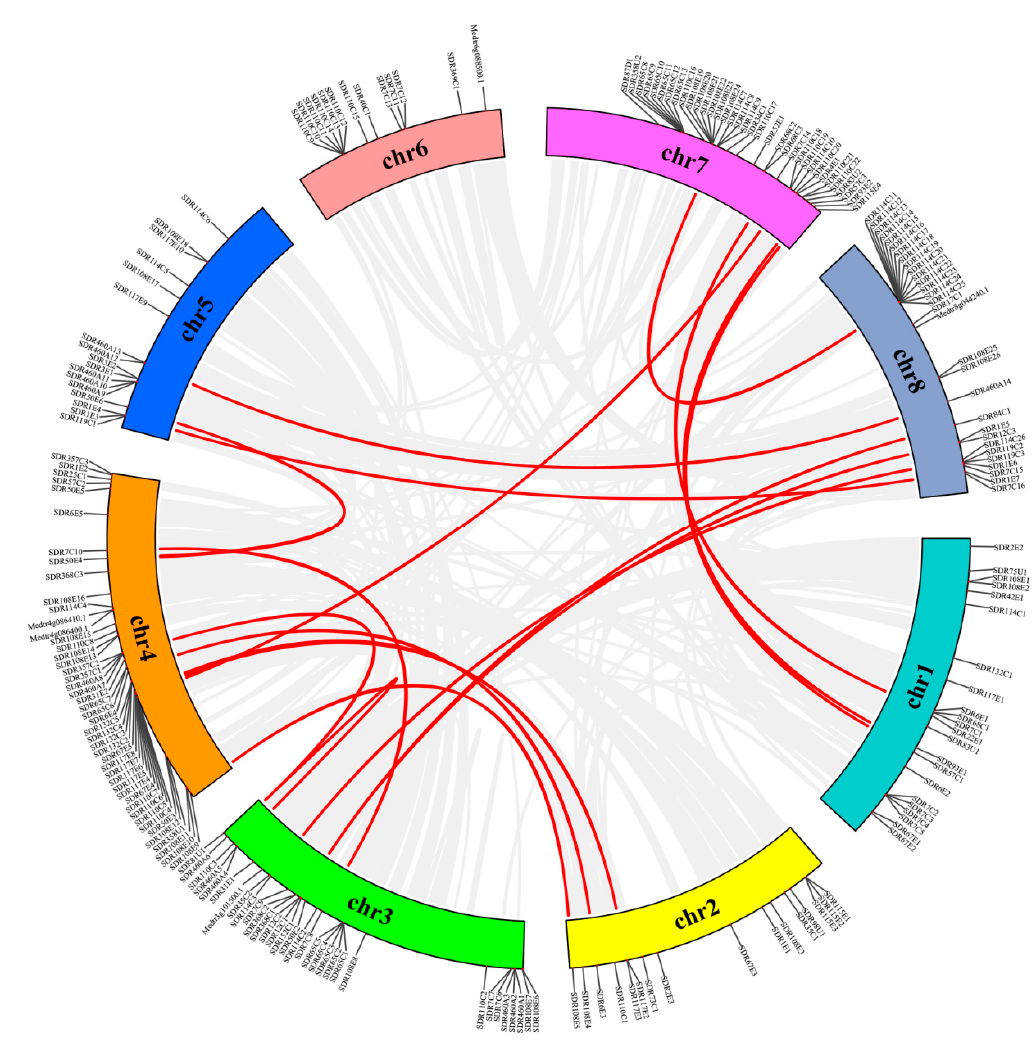
Figure 3. Synteny analysis of interchromosomal relationships of MtSDR genes. Red lines indicate duplicated gene pairs.